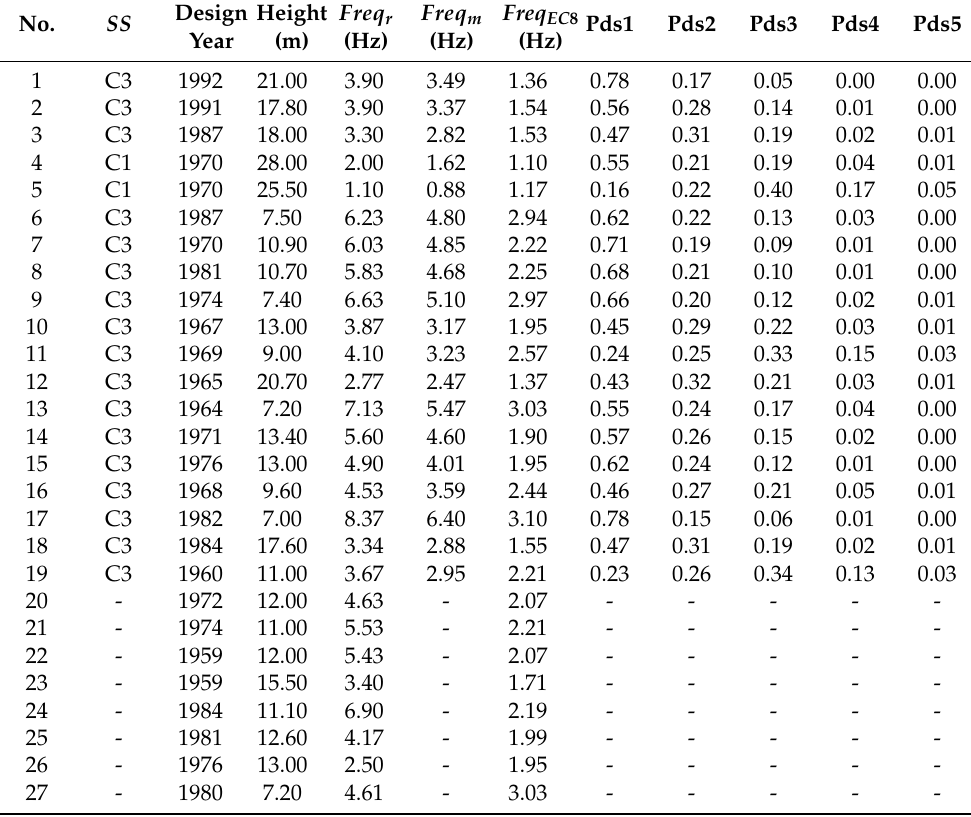
Table 1. Experimental data collected from 27 RC Buildings.